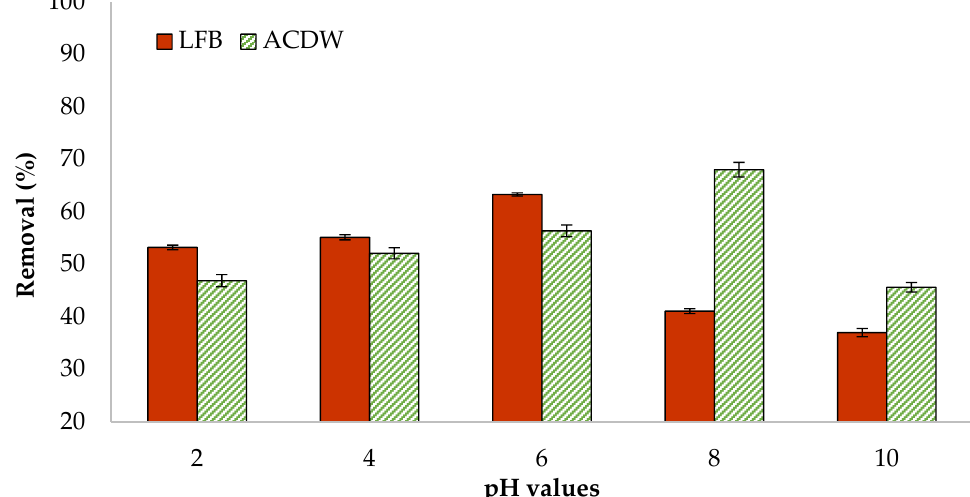
Figure 4. Influence of pH value on the adsorption of ammonia using whole biomass (ACDW) and lipid-free biomass (LFB) of Arthrospira platensis .